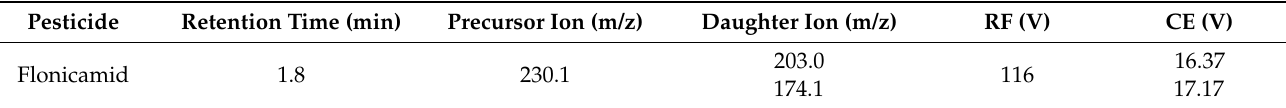
Table 1. Collection parameters of the MRM of